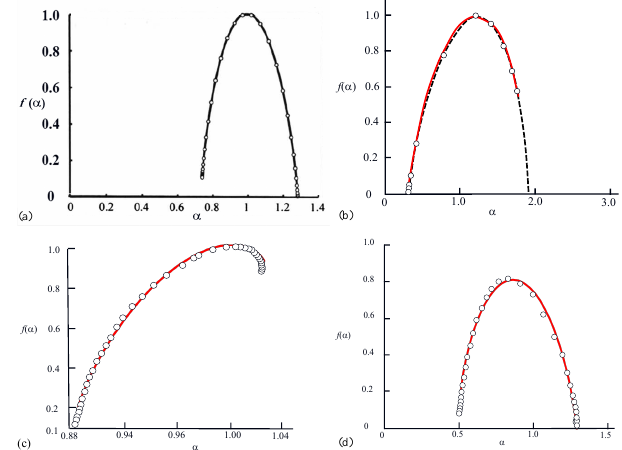
Fig. 3. Results showing fractal dimension functions (dots) calcu- lated by previous authors published in literature and fitted by the five-parameter binomial multiplicative cascade model proposed in the current paper (solid line). (a) Fractal dimension spectrum cal- culated for de Wijs’s zinc values by means of gliding-box method (Cheng, 1999b) and binomial multiplicative cascade model with m 1 = 1, m 2 = 1 . 1, h = 2 . 1, d 1 = 0 . 38, and d 2 = 0 . 63. (b) Fractal dimension spectrum calculated for the energy transfer rate in the solar wind turbulence at solar minimum (2006) fitted by the model proposed by Szczepaniak and Macek (2008) (dashed line). The red solid line fitted by the five-parameter binomial multiplicative cas- cade model with m 1 = 1, m 2 = 1 . 74, h = 2 . 74, d 1 = 0 . 738, and d 2 = 0 . 292. (c) Fractal dimension spectrum calculated for time se- ries of synthetic earthquakes by Muñoz-Diosdado et al. (2004) and binomial multiplicative cascade model with m 1 = 7 . 17, m 2 = 1 . 54, h = 8 . 71, d 1 = 0 . 779, and d 2 = 0 . 226. (d) Fractal dimension spec- trum calculated for human posture data by wavelet transform mod- ulus multifractal method (WTMM) (Shimizu et al., 2002) and bi- nomial multiplicative cascade model with m 1 = 1 . 219, m 2 = 1 . 00, h = 2 . 69, d 1 = 0 . 728, and d 2 = 0 .